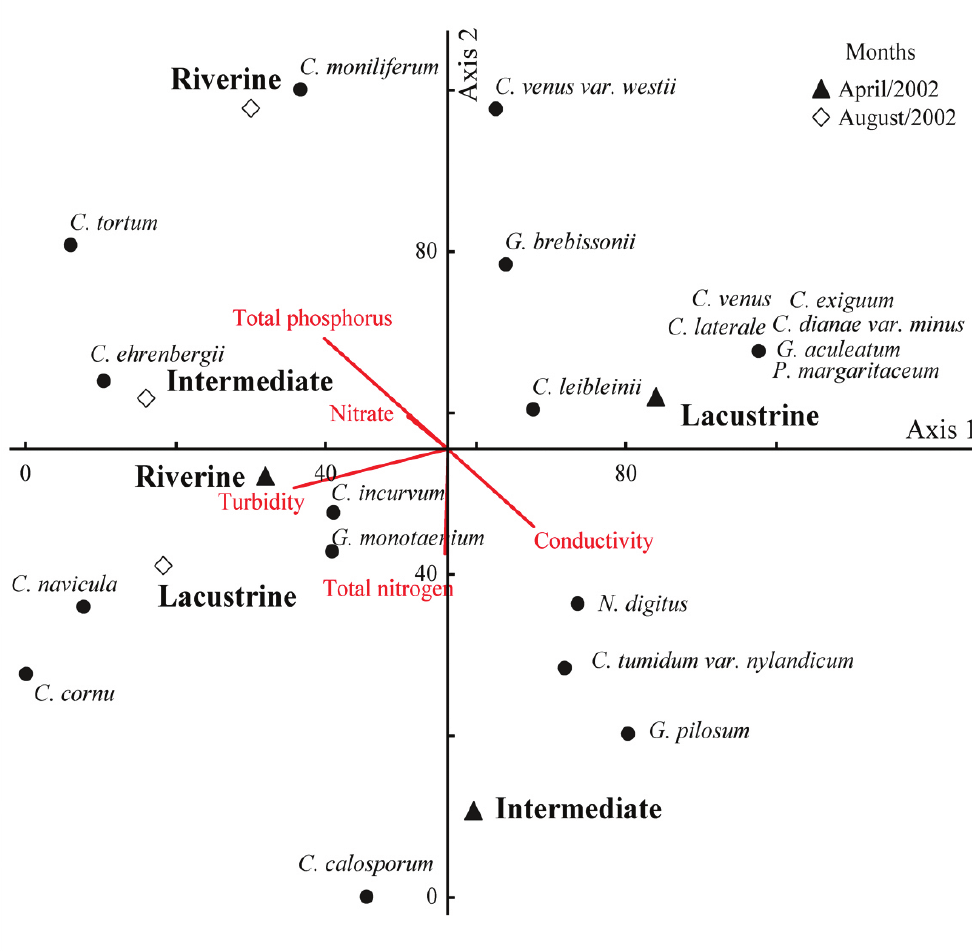
Figure 4. Ordination by the Canonical correspondence analysis (CCA) of abiotic variables and species, analyzed for the six sampling sites along the Rosana Reservoir, from April/2002 and